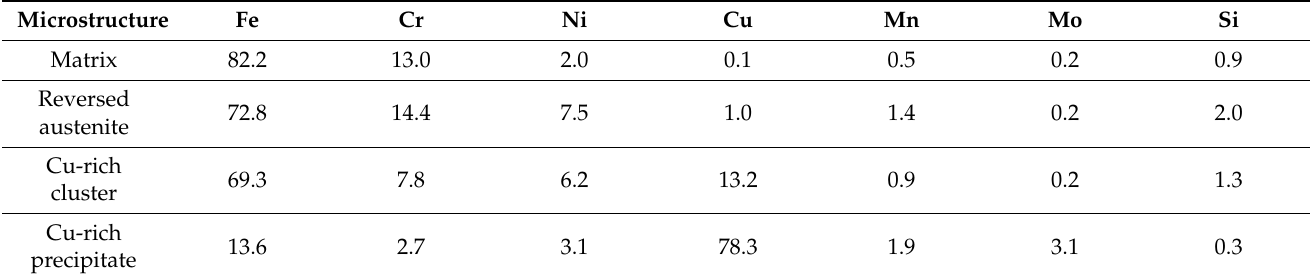
Table 3. Chemical compositions in different microstructures of 3Cu-Steel (at.%).